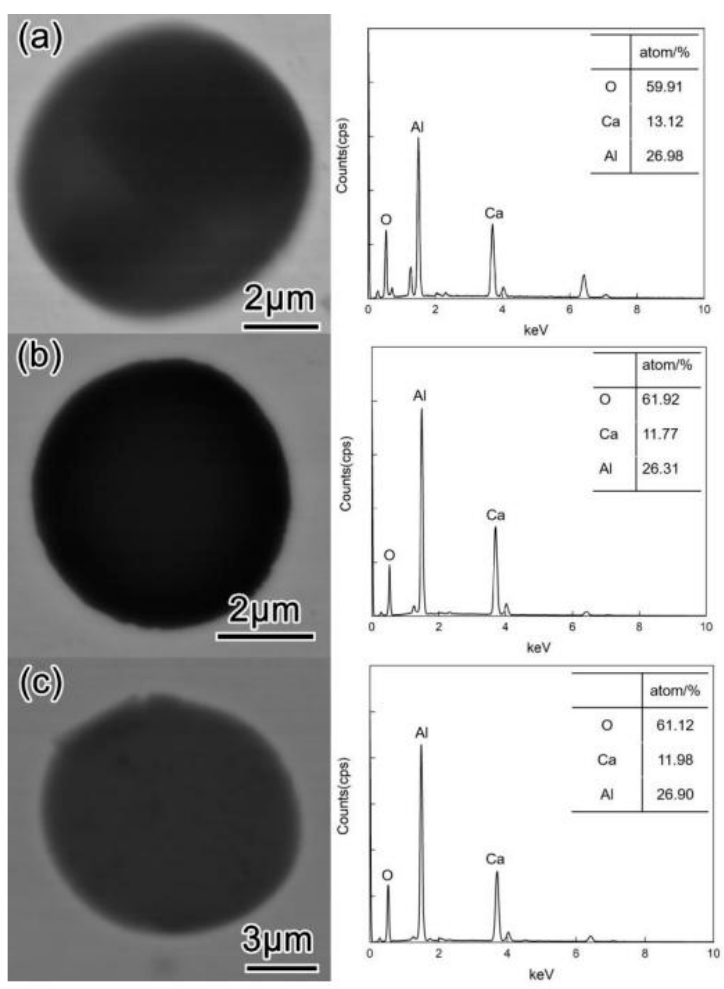
Figure 4. Typical morphology of inclusions in steel before adding rare earth alloy (T1): ( a ) L–Ce; ( b ) M–Ce; ( c ) H–Ce.